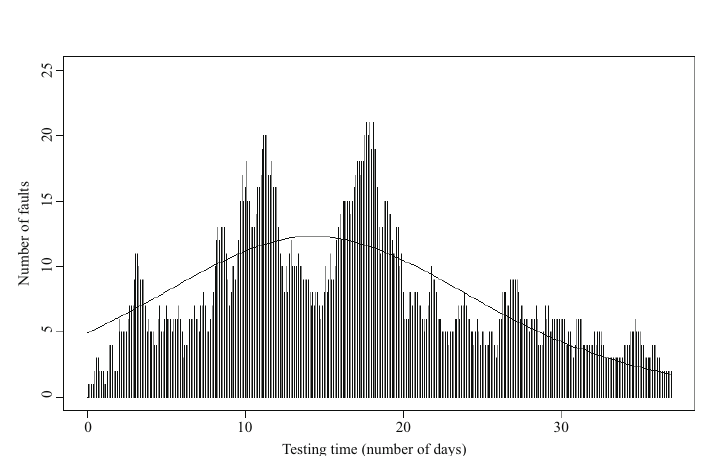
Figure 10. Behavior of the number of faults being corrected (the correction time is 1.0 day/fault on average, ISS